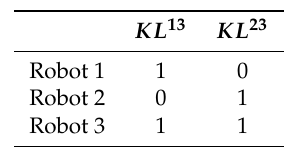
Table 4. The simplified signature matrix of robot 3.